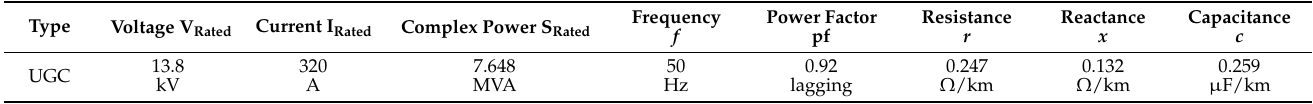
Table 2. Underground Cable (UGC) parameters and rated